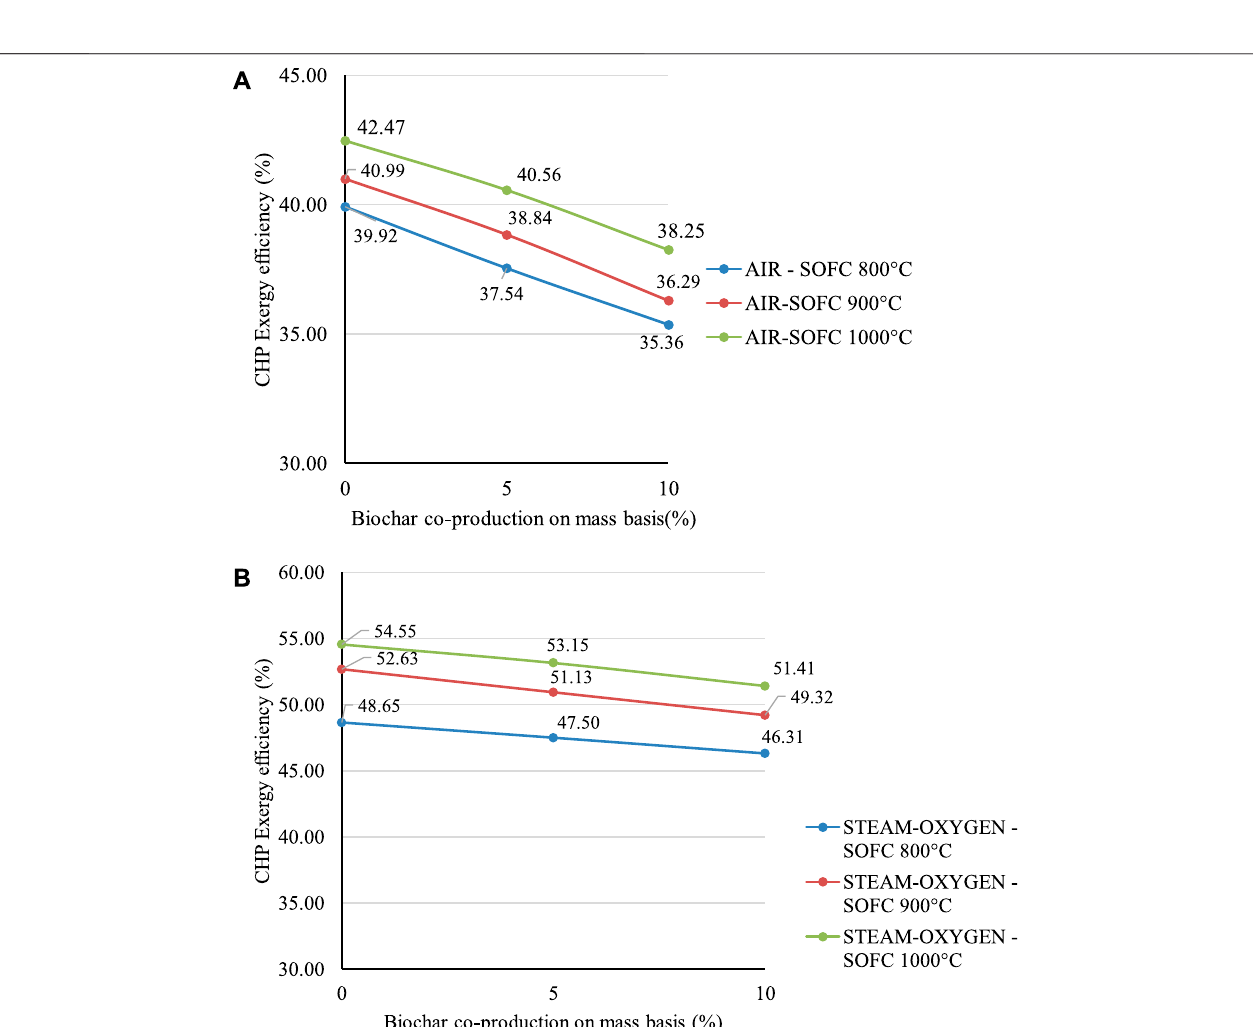
FIGURE 7 | (A) Effect of different operating temperatures of the SOFC on CHP exergy ef fi ciency for the air gasi fi cation case. (B) Effect of different operating temperatures of the SOFC on CHP exergy ef fi ciency for the steam-oxygen gasi fi cation case.